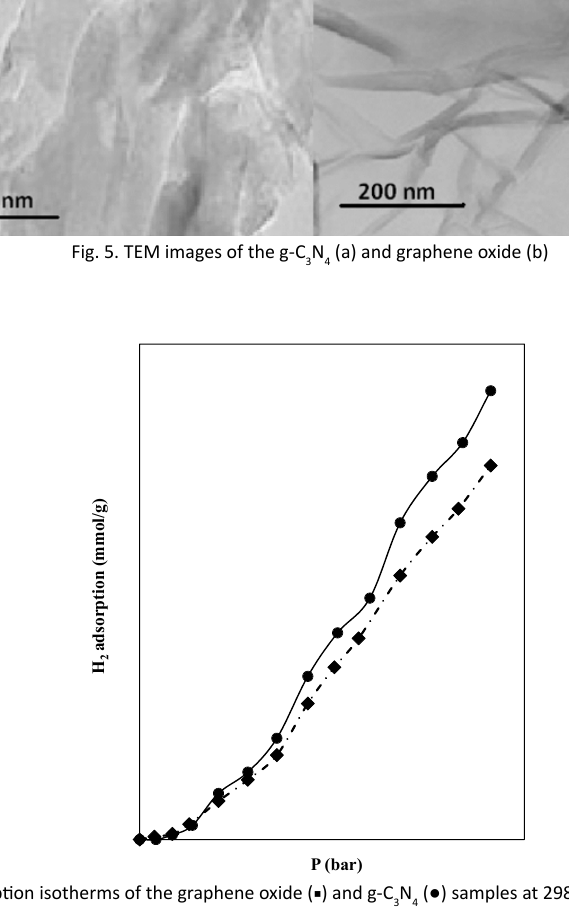
N (●) samples at 298 K and pressures up to 22 3 4